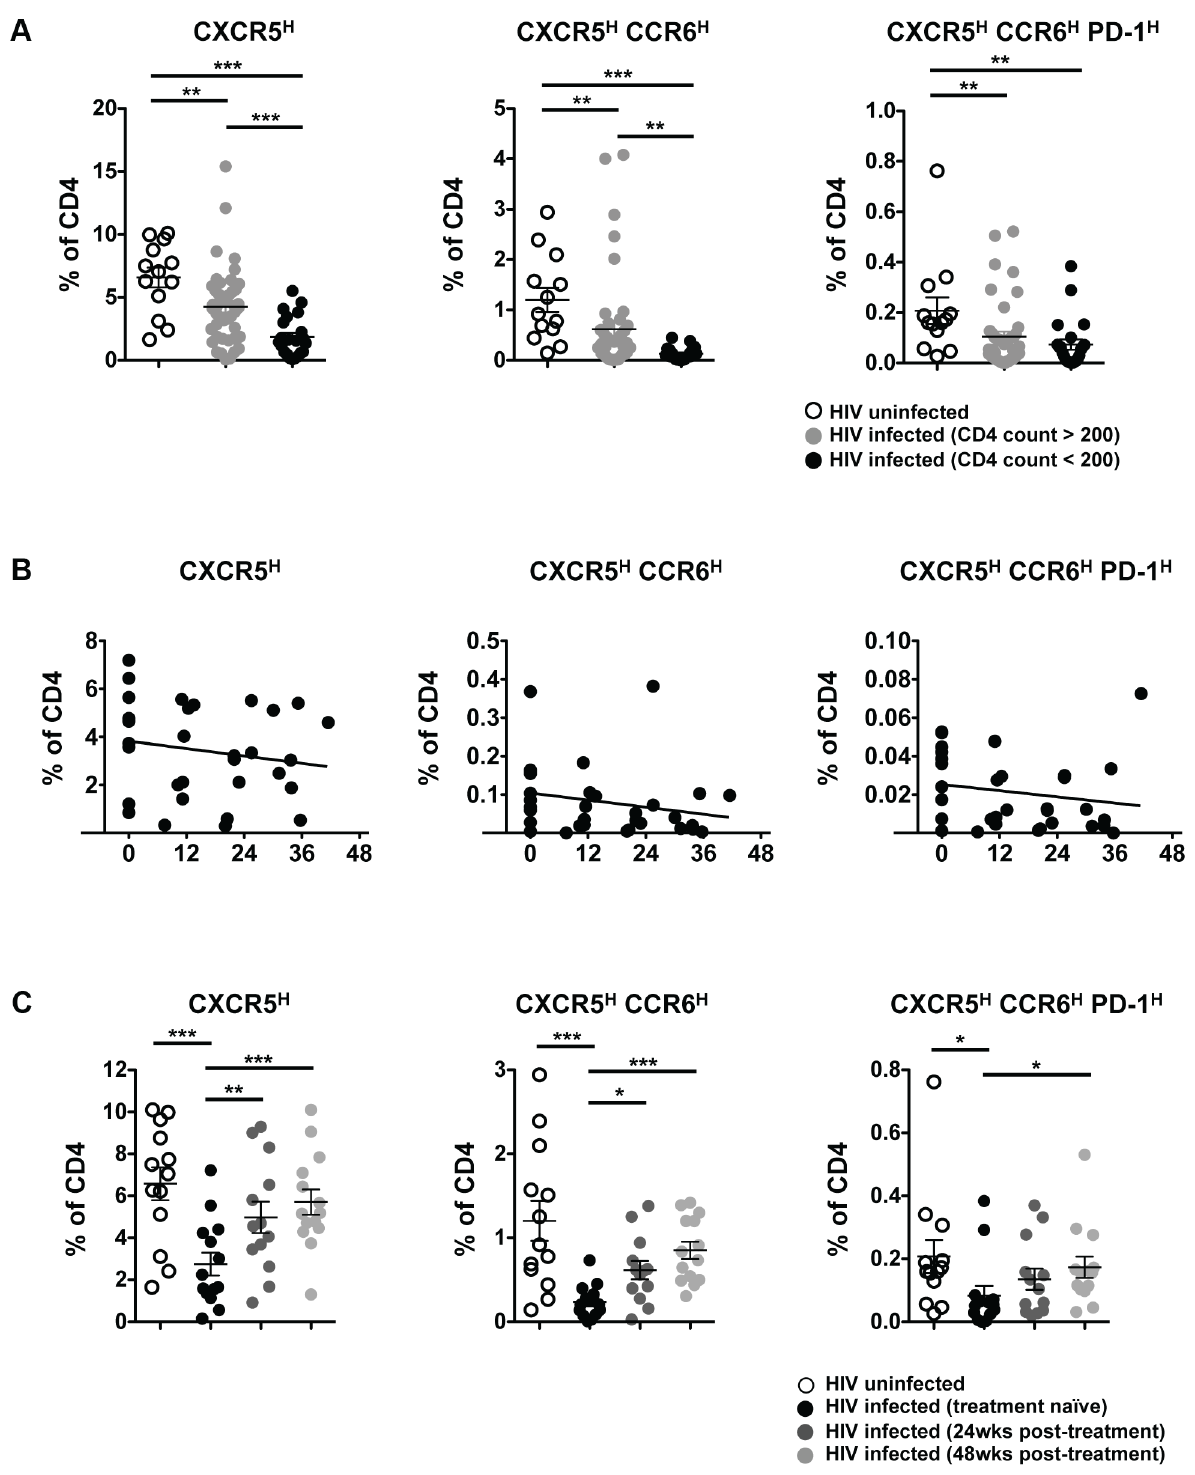
Figure 2. Progressive loss of pT FH cells in HIV infection. ( A ) Pooled data showing the frequency (%) of CXCR5 high , CXCR5 high CCR6 high and CXCR5 high CCR6 high PD-1 high populations in total CD4 cells from PBMC from HIV uninfected (open circles; n=13), HIV-infected (treatment-naı¨ve), CD4 count . 200 (light gray circles; n=44), and HIV-infected (treatment-naı¨ve), CD4 count , 200 (black circles; n=22). Significant differences between HIV- uninfected and HIV-infected subjects were determined using the Mann-Whitney U test. ***p , 0.001; **p , 0.01; *p , 0.05. ( B ) Longitudinal analysis showing the frequency (%) of CXCR5 high , CXCR5 high CCR6 high and CXCR5 high CCR6 high PD-1 high populations in total CD4 cells or indicated populations in CXCR5-expressing cells (bottom row) from HIV-infected (treatment naı¨ve) subjects (n=10) over 36–48 months. No significant correlations were found. ( C ) Pooled data showing the frequency (%) of CXCR5 high , CXCR5 high CCR6 high and CXCR5 high CCR6 high PD-1 high populations in total CD4 cells from PBMC from HIV-uninfected subjects (open circles; n=13) and HIV-infected subjects before (n=14, week 0; black circles) and after ART (week 24, dark